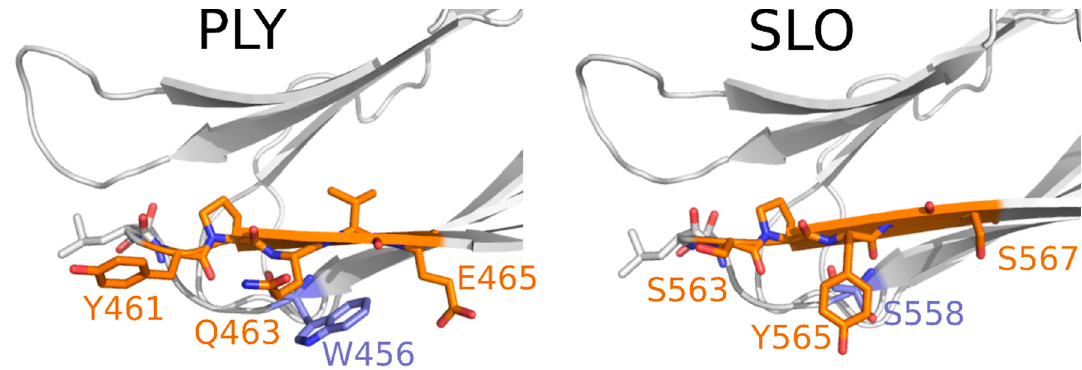
Figure 8. MAb binding sites in D4 of PLY ( left ) and SLO ( right ). Tryptophan W456 (PLY) and serine S558 (SLO) are shown in violet; the other predicted epitope residues are coloured in orange. The differences in binding specificity of MAbs 3A9 and 12F11 for different cytolysins are harder to explain, however the same residues may also be important for the interaction in the region of aa